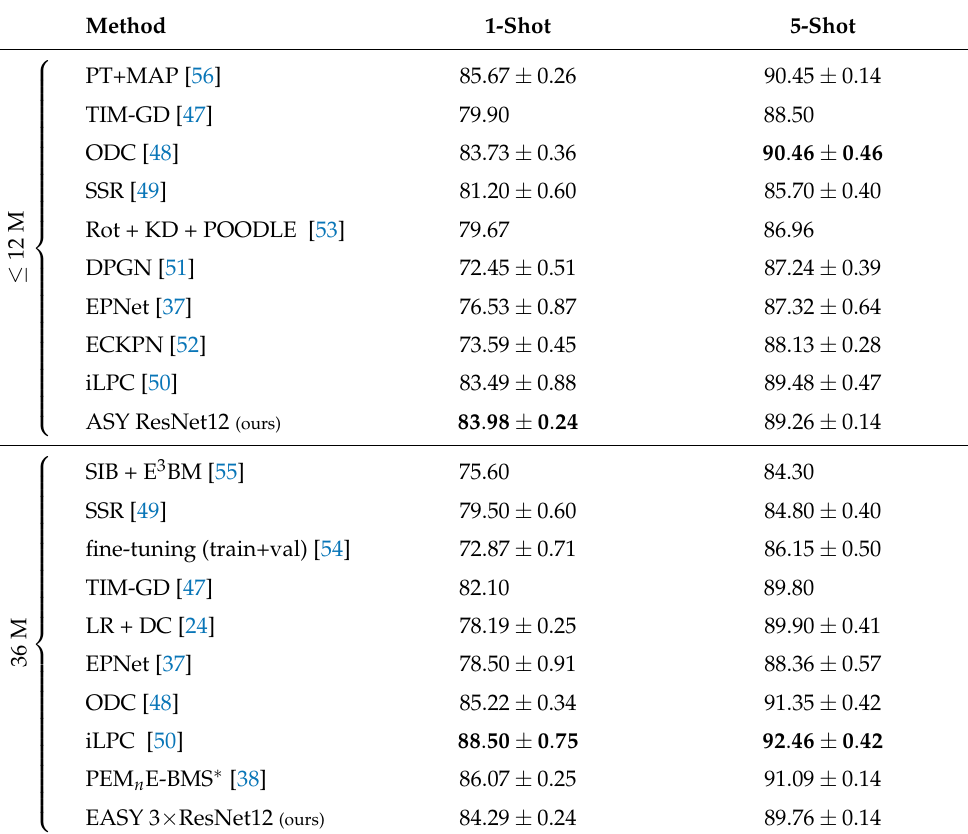
Table 10. The 1-shot and 5-shot accuracy of state-of-the-art methods and the proposed solution on TieredImageNet in the transductive